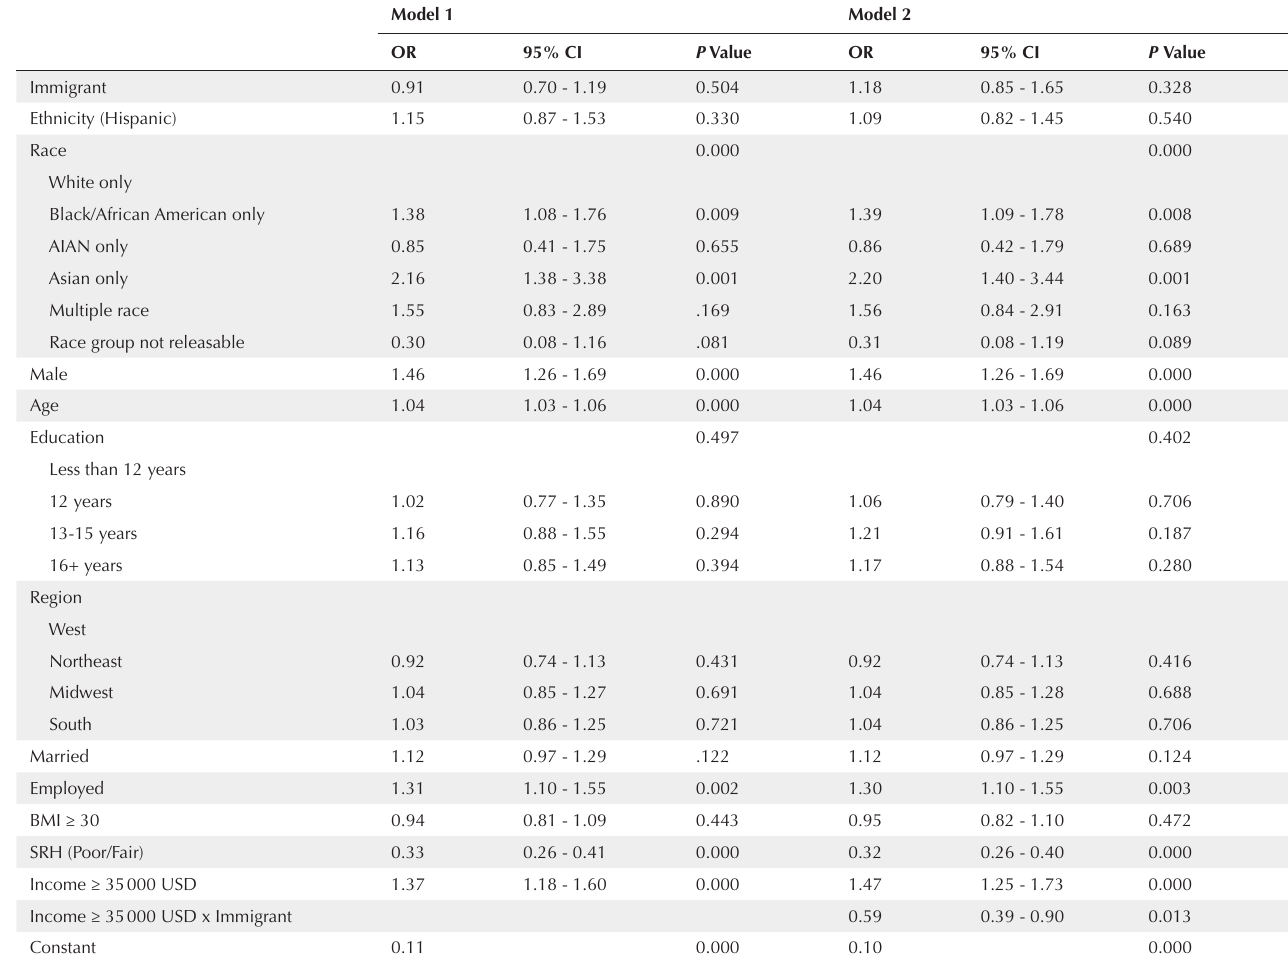
Table 2. Logistic Regressions in the Pooled Sample (n=14 149) Model 1 Model 2 OR 95% CI P Value OR 95% CI P